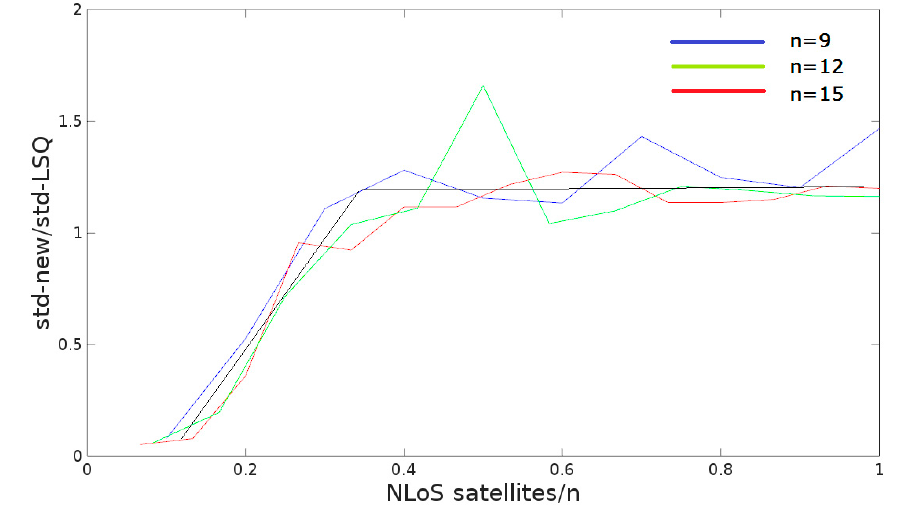
Figure 2. Algorithm verification using simulation in relative values.